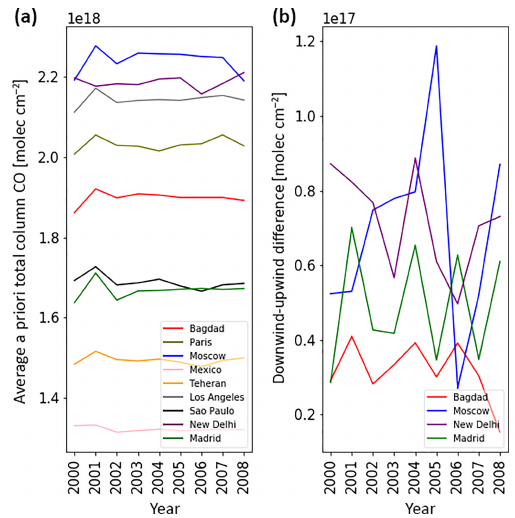
Figure 6. (a) Variations in annual mean a priori total column CO over the years due to uneven sampling. Averages were made over the 200 × 200km 2 domain around each city. (b) Variations in an- nual mean downwind–upwind differences in total column a priori CO over the years. Only cities with a distinct city-like pattern in the a priori are